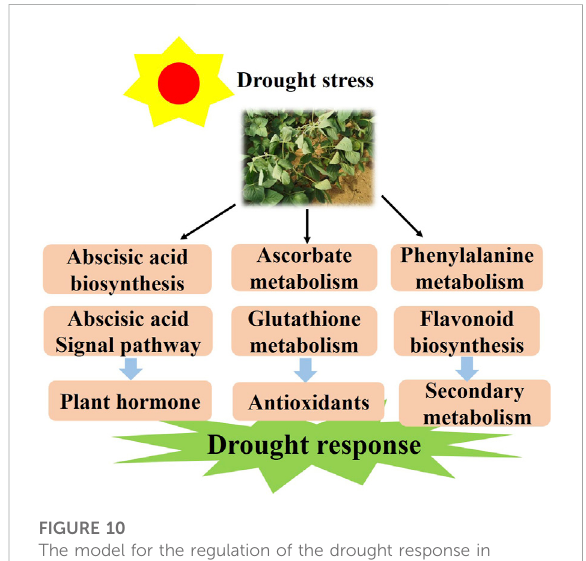
FIGURE 10 The model for the regulation of the drought response in soybean responds to drought conditions by regulating the plant hormone, antioxidant and fl avonoid